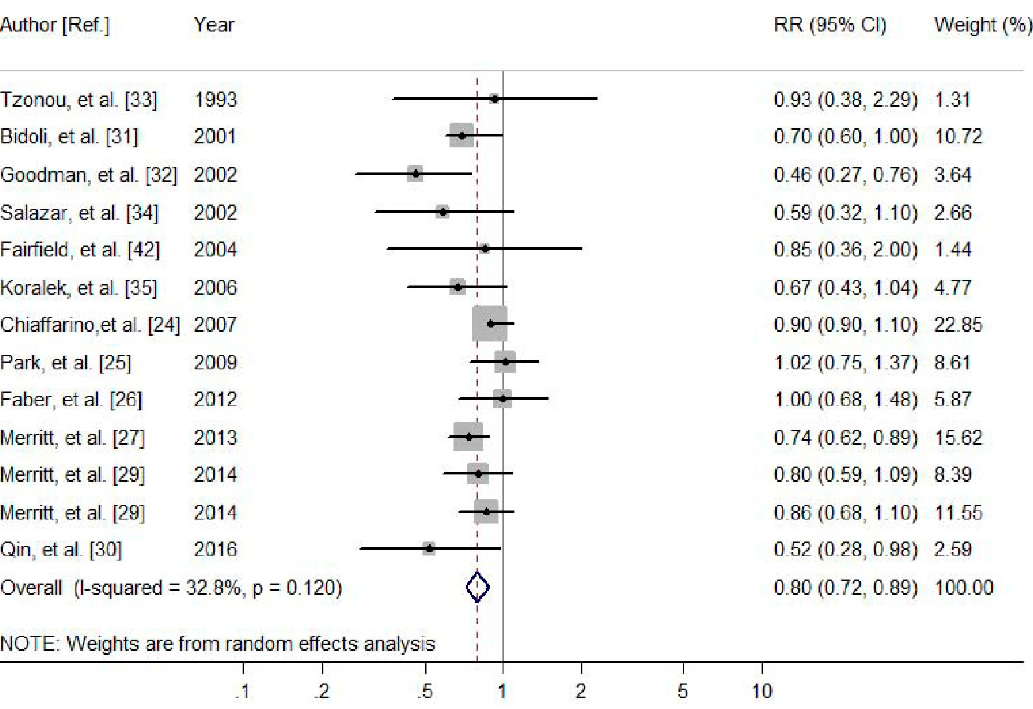
Figure 2. Meta-analysis of the association between dietary calcium intake and ovarian cancer risk. The size of the gray box is positively proportional to the weight assigned to each study, which is inversely proportional to the standard error of the relative risks, and horizontal lines represent the 95% confidence intervals.